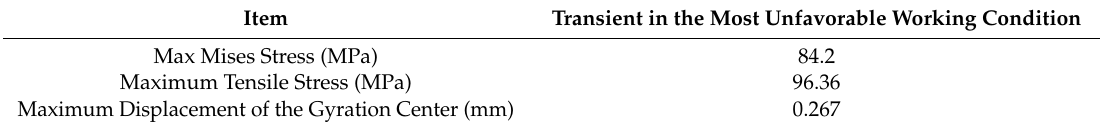
Table 5. The static analysis result of the optimized upper arm in the most unfavorable working condition.